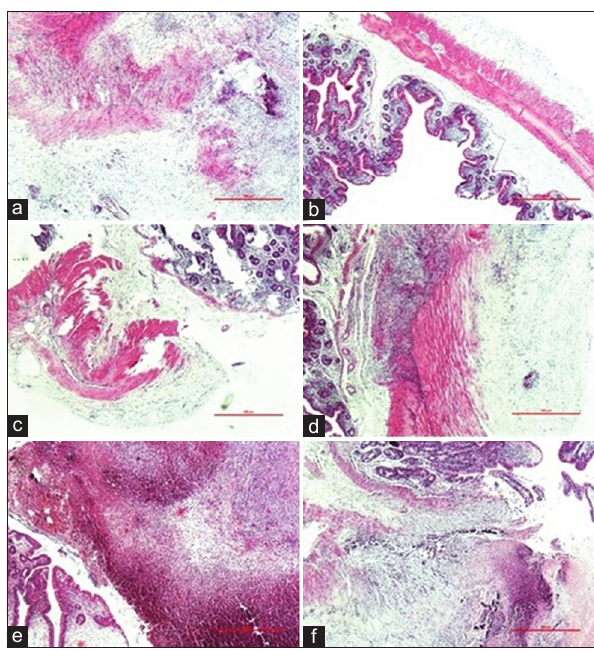
Figure-1: (a) Animal C1, thickening of the muscular and submucosal layer of caecum, serosal vascular proliferation. (b) C3, slight infiltration in the mucosa and submucosa, normal serosa. (c) PG2, slight mucosal infiltration, slight infiltration and vascular proliferation in the serosa. (e) GP3, necrosis and thickening of submucosal, muscular and serosal layer of caecum. (f) GP5, mucosal, submucosal, muscular and serosal layer showing diffuse thickening and vascular proliferation. Haematoxylin-eosin